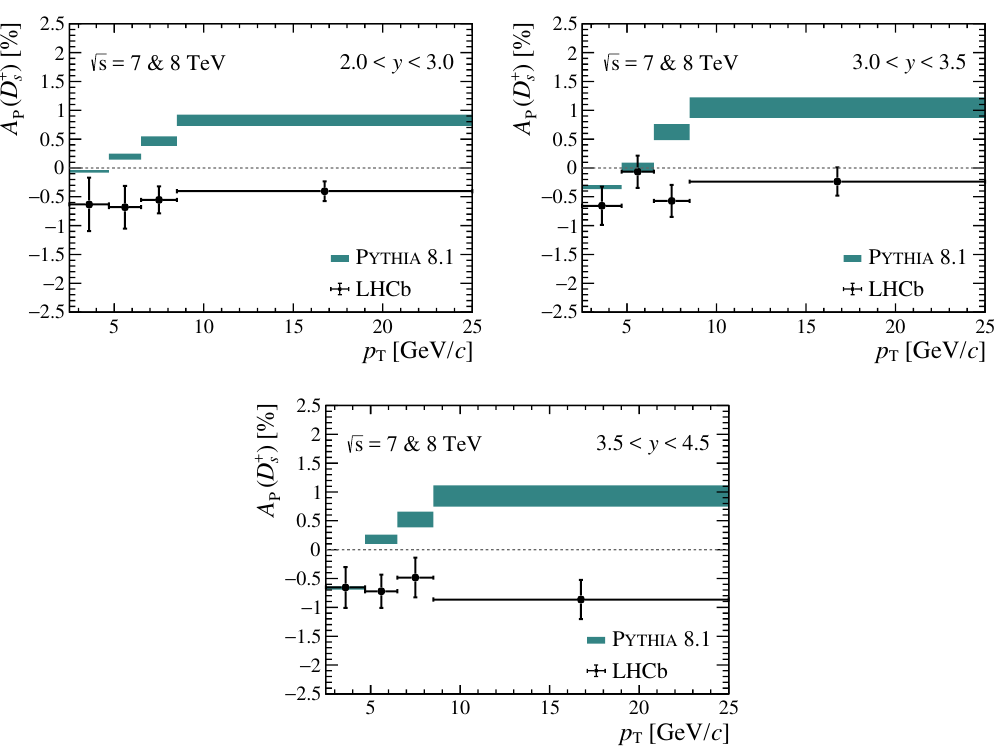
Figure 3 . Results of the LHCb measurement of the D + for three di(cid:11)erent bins of rapidity, compared to the results from Pythia . Both are for the combined p s = 7 and 8 TeV data sets. The uncertainties on the Pythia predictions are statistical only.